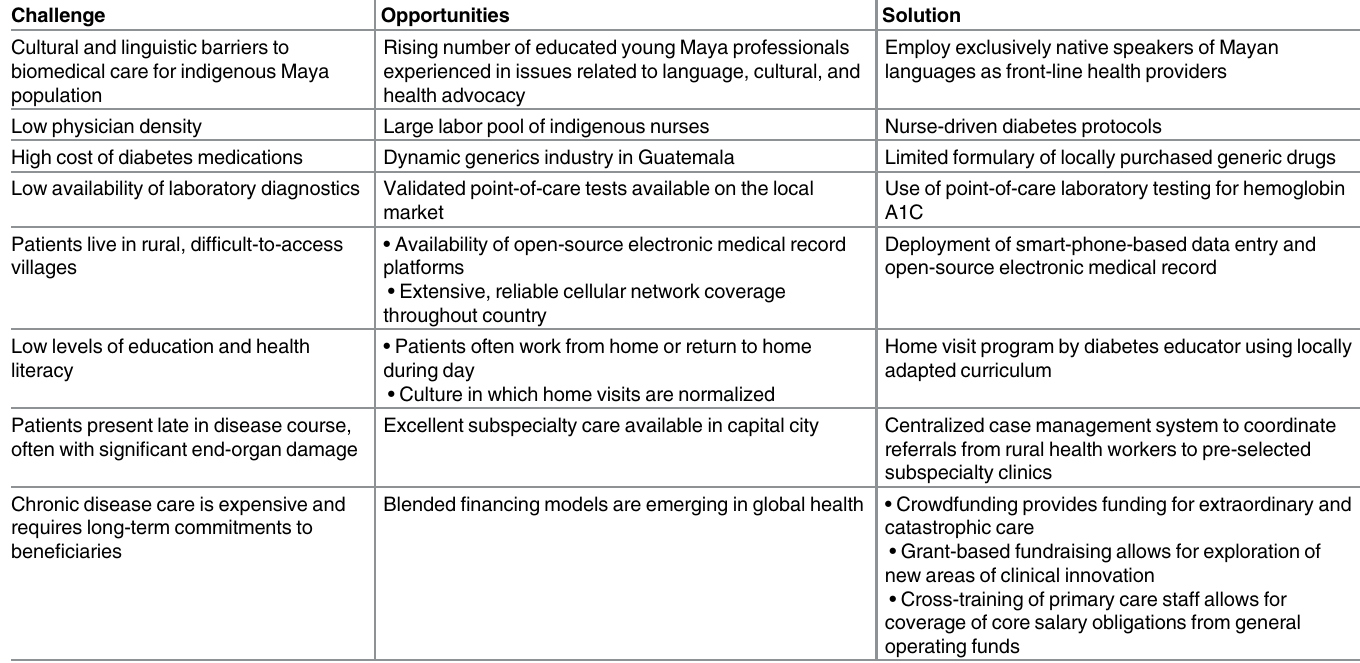
Table 1. Challenges, Opportunities, and Solutions for Implementation of Diabetes Programs in